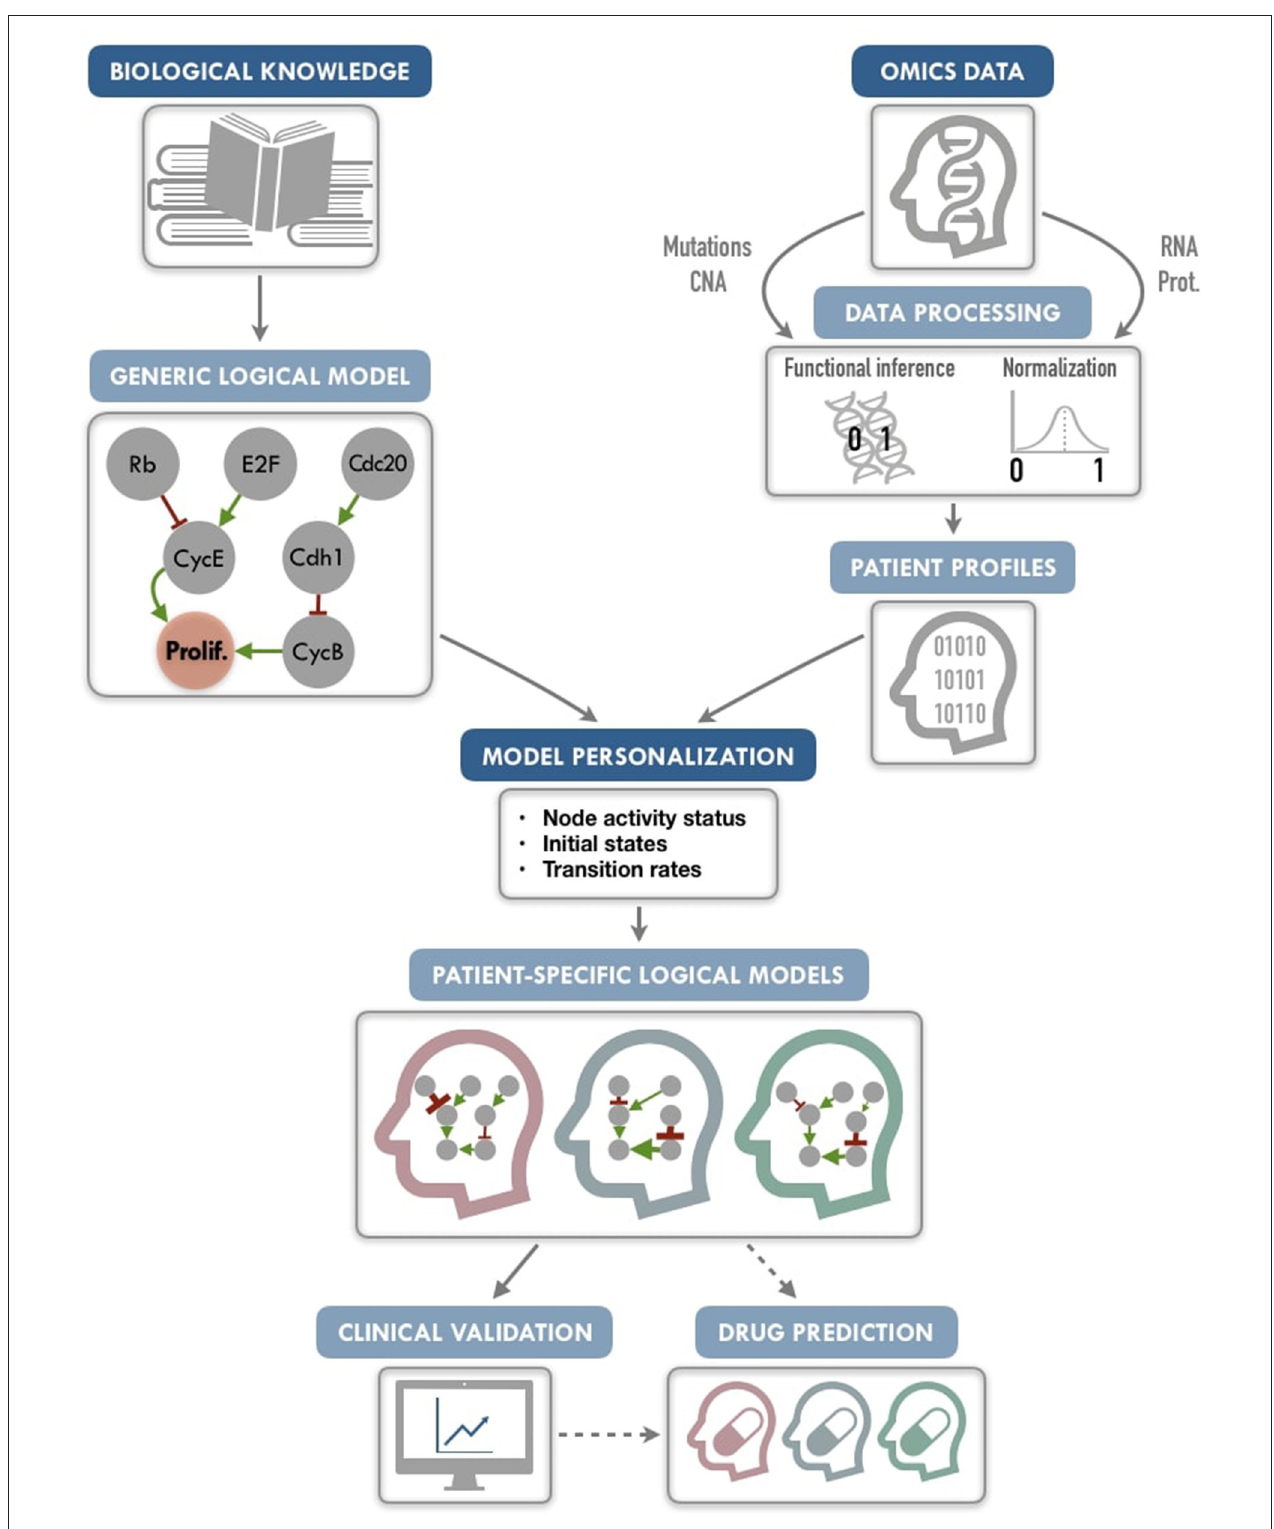
FIGURE 1 | PROFILE methodology for personalization of logical models. On the one hand (upper left), a generic logical model, in a MaBoSS format (a BND file for model description with logical rules and a CFG file for definition of the simulation parameters), is selected to serve as the starting-point. Note that any SBML qual